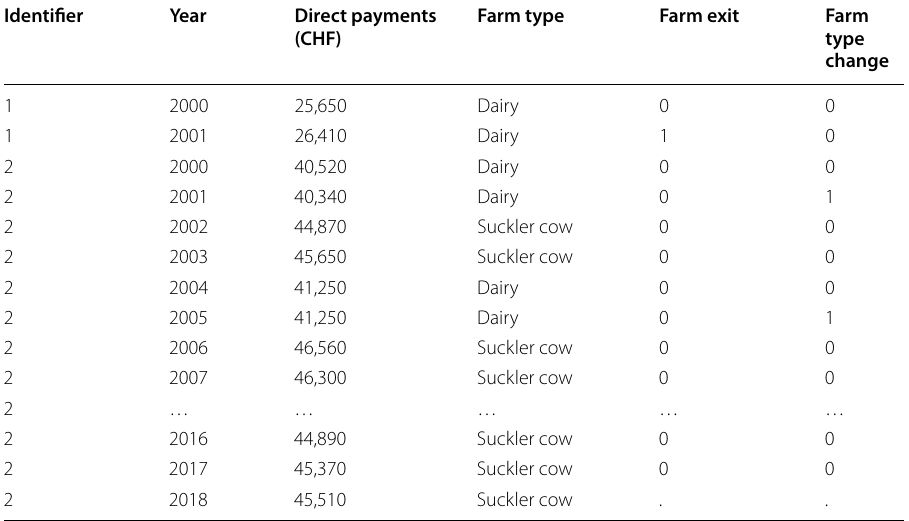
As a result of this definition of outcome variables, the last year of observation is not used in the following analysis and marked as missing value